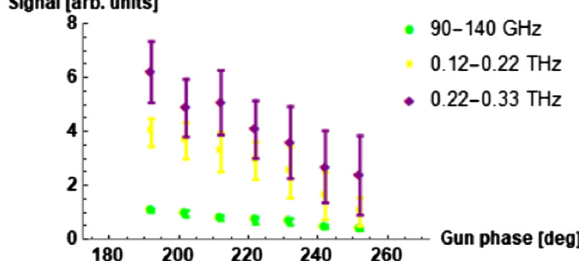
FIG. 7. Signature of the bunch compression versus the gun phase, recorded for different ranges of frequency in the sub-THz domain. When the bunch length is shortened from many ps down to ≲ 1 ps, the “ high ” -frequency Schottky diodes detect greater signals of coherent radiation.